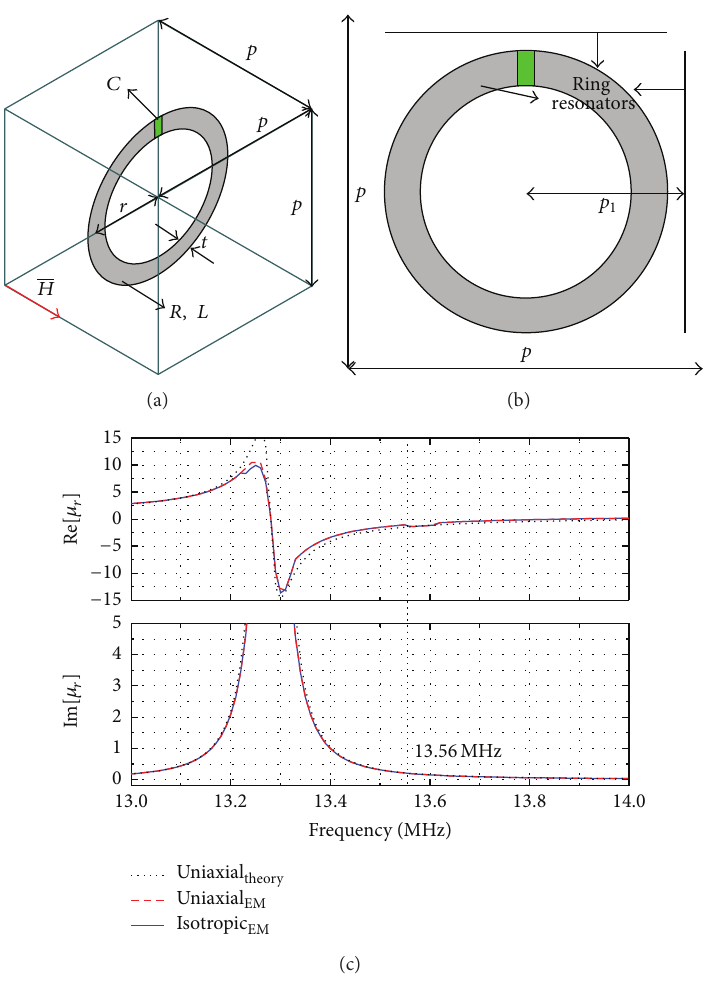
Figure 3: Ring resonators and their relative effective permeability. (a) Uniaxial unit cell, (b) isotropic unit cell ( 𝑝 1 = 5.5 cm), and (c) theoretical (7) and extracted permeability using 𝑆